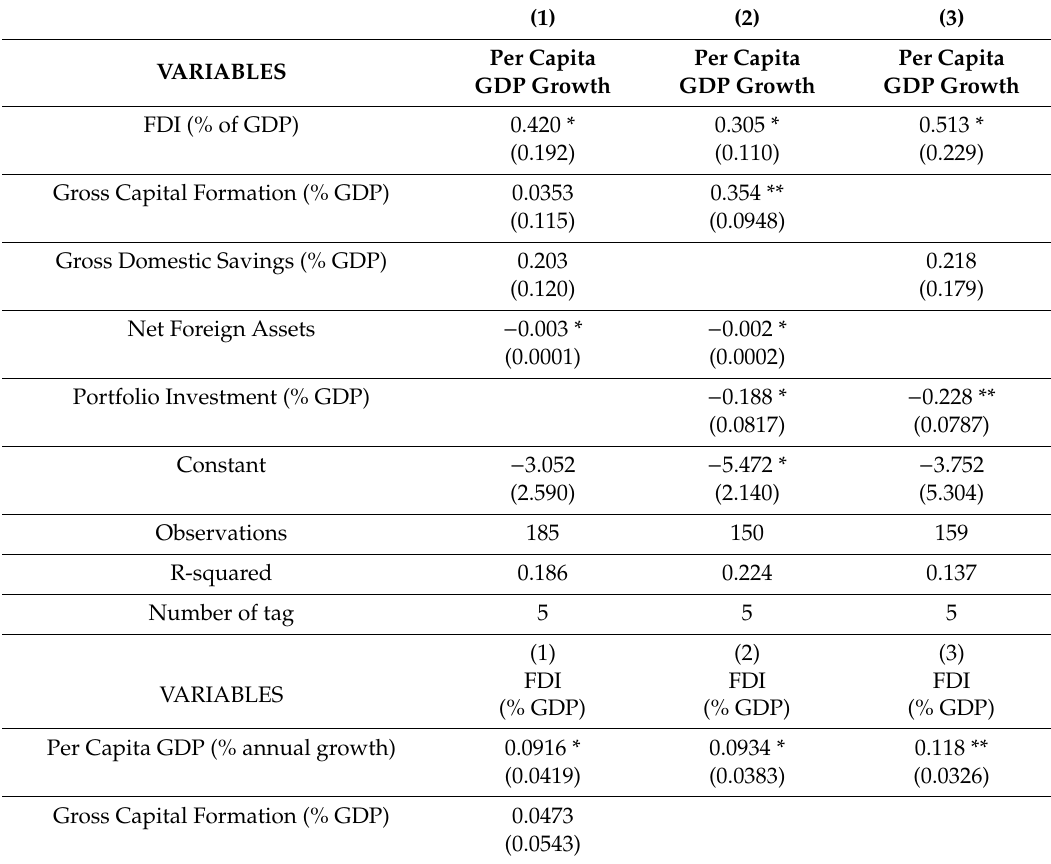
Table A1. Panel fixed-e ff ect